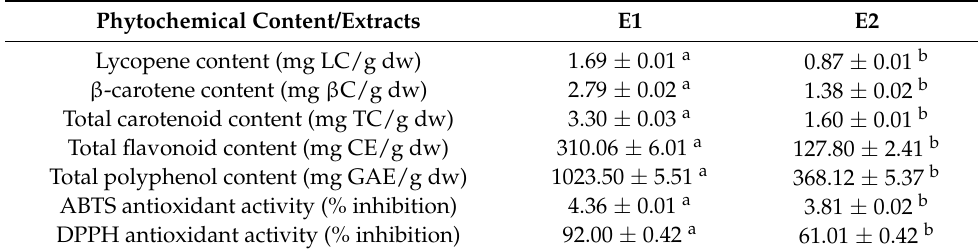
Table 2. Phytochemical profile of the sea buckthorn extracts. Phytochemical